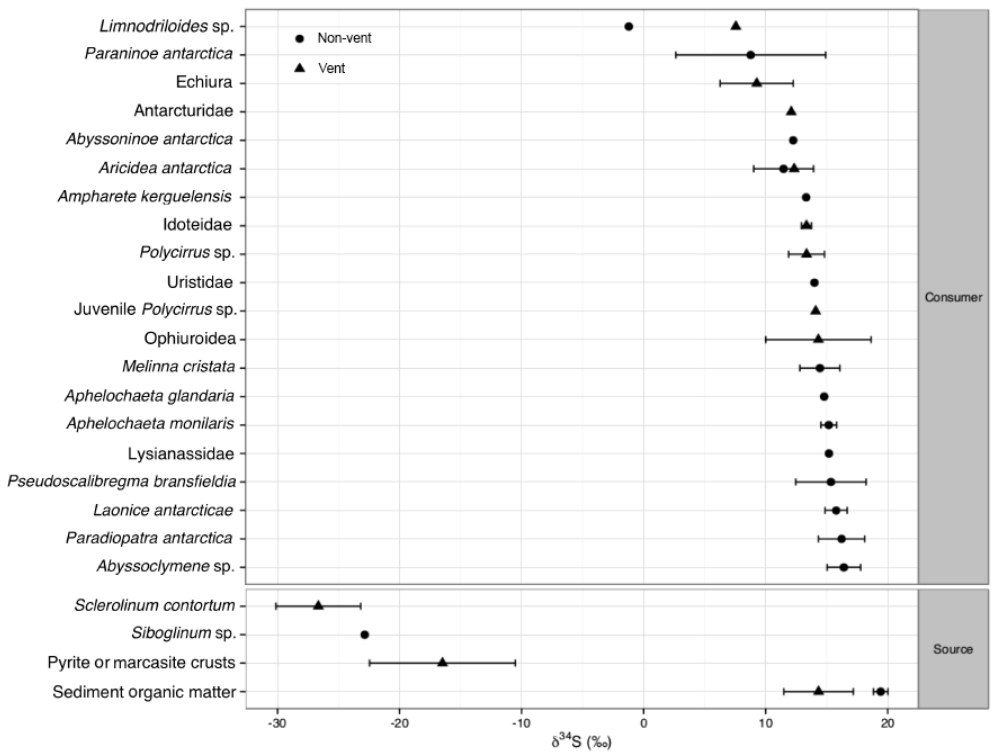
Figure 4. Plot of δ 34 S measurements discriminated by species and habitat (hydrothermally active vents and sediments or non-hydrothermally active sediments ± 1SD). Data for δ 34 S in crusts from Petersen et al.